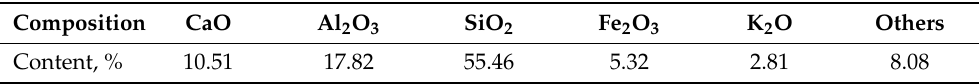
Table 3. Main chemical composition of Fly